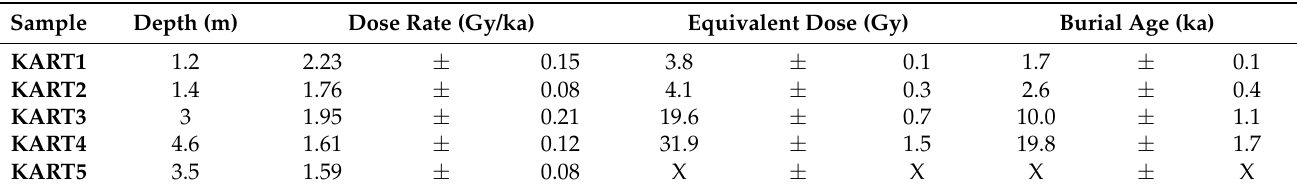
Table 2. Environmental dose rates, estimated equivalent doses and derived burial OSL